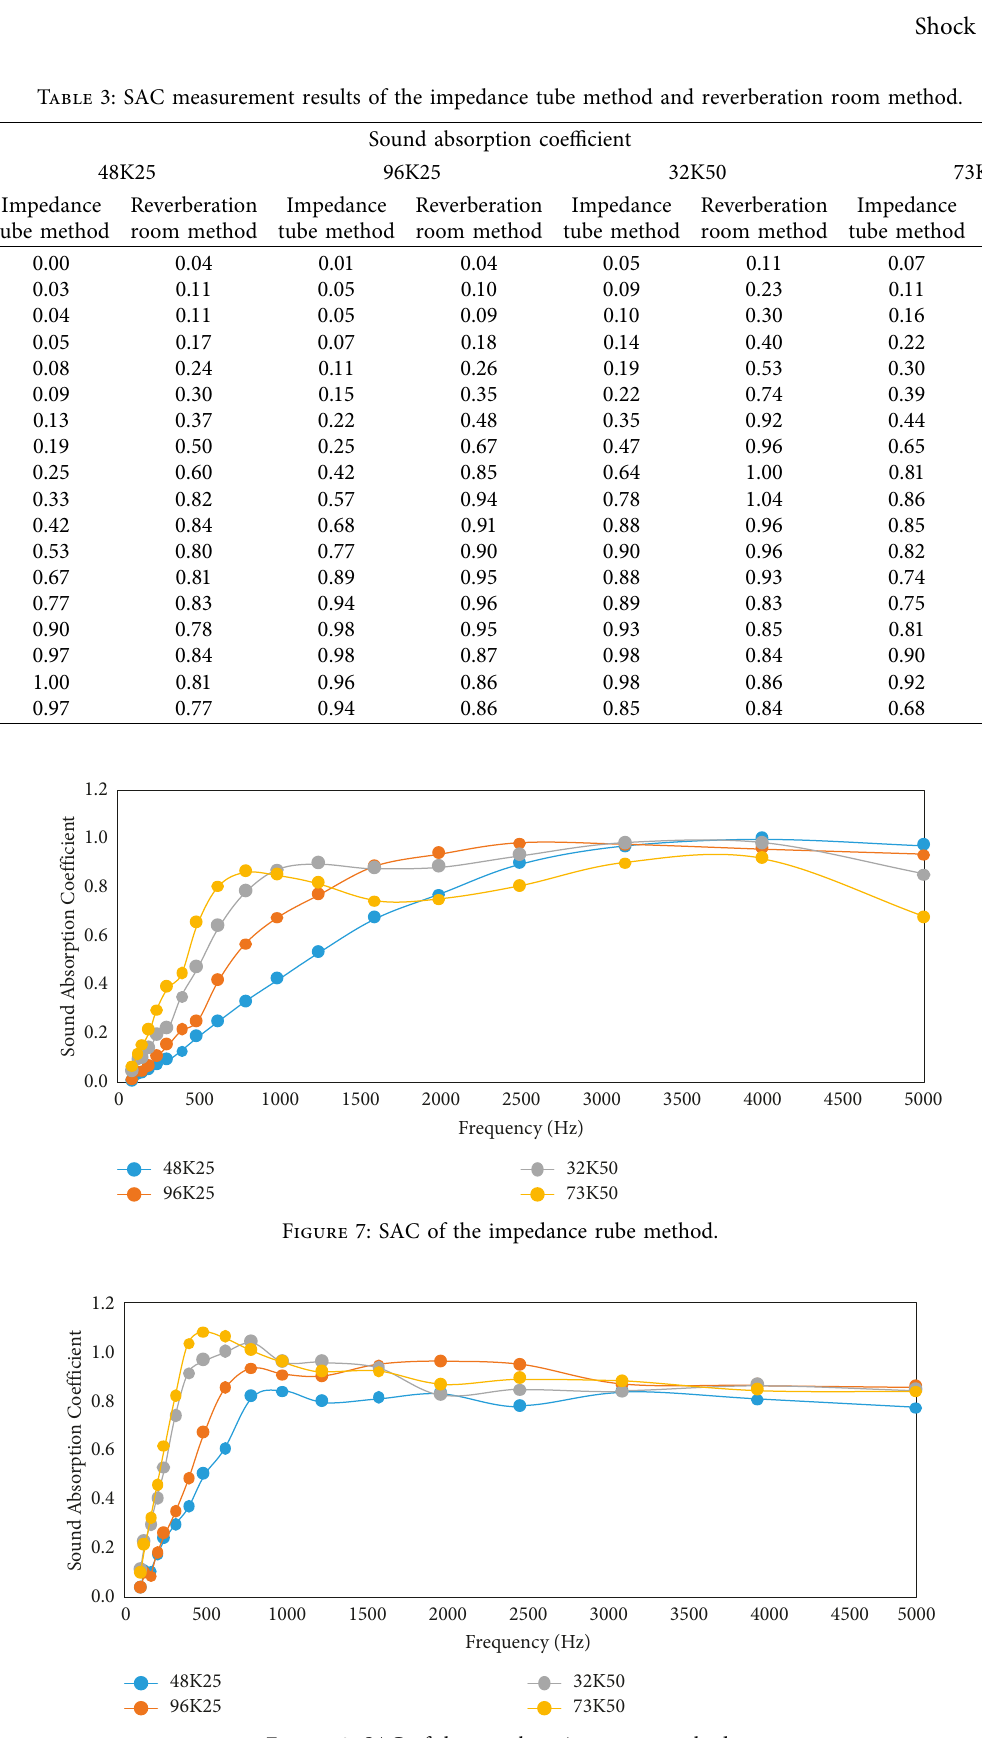
Figure 8: SAC of the reverberation room